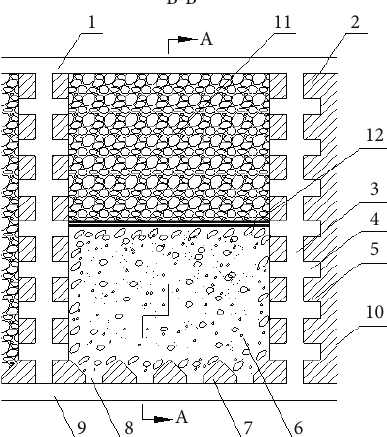
Figure 2: Numerical test model of the synchronous fi lling shrinkage